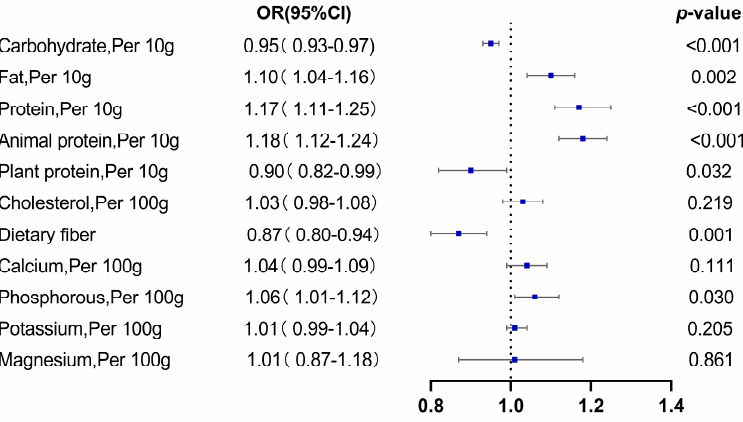
( b ) Figure 3. Multivariate adjusted odds ratios (ORs) by PRAL ( a ) and NEAP ( b ) for risk of hyperurice- mia, in model 3. A knot is located at the 10th, 50th and 90th percentiles. The median intakes were set as references (gray dashed lines) (OR = 1.00). CI, con fi dence interval. 3.4. Association between Dietary Intakes and Hyperuricemia After adjustment, every 10 g increase in energy-adjusted fat, protein and animal pro-